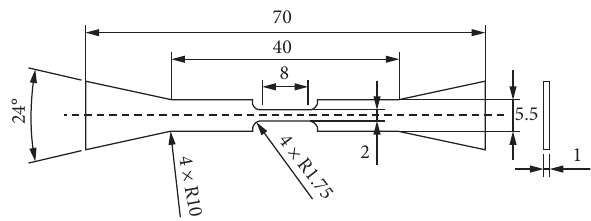
Figure 2: Specimen size (unit: mm).